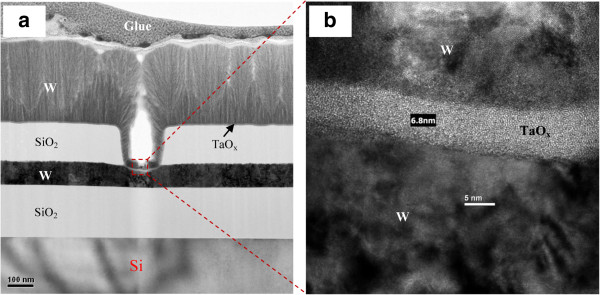
TEM image of W/TaOx/W structure. (a) Cross-sectional TEM image with a device size of 0.15 × 0.15 μm2. (b) HRTEM image inside the via-hole region. The thickness of TaOx film is approximately 6.8 nm.